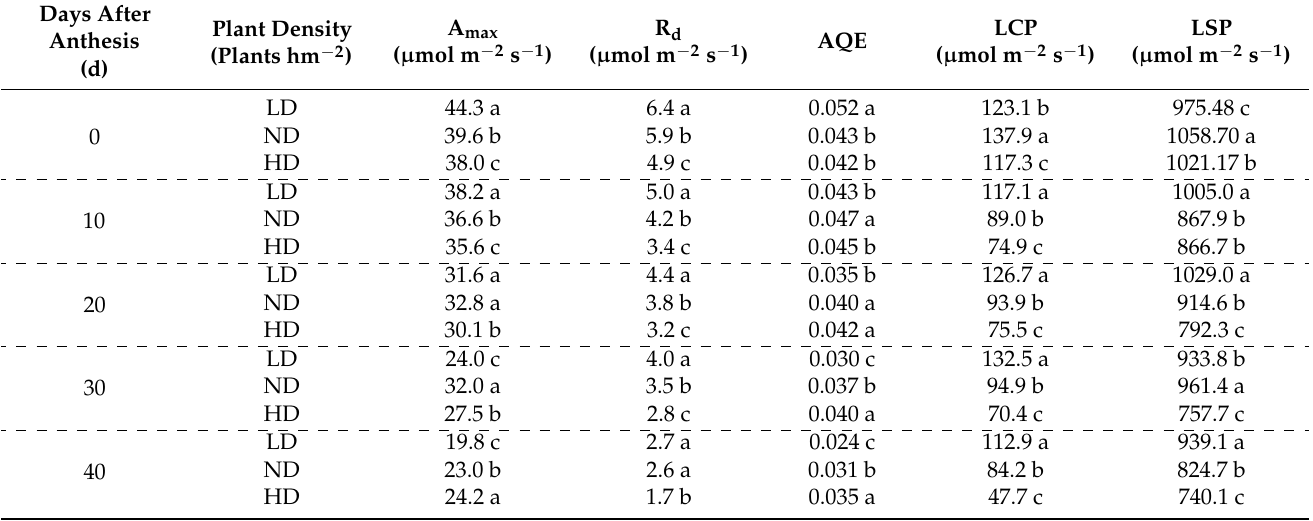
Table 1. Mean values ± SD ( n = 3) of photosynthetic parameters derived from the photosynthetic photon flux density (PPFD) response curves in maize plants grown under low (LD), normal (ND), and high density (HD) planting at 0, 10, 20, 30, and 40 d after anthesis. Different lowercase letters (a, b, c) denote statistical differences by LSD test ( p ≤ 0.05) between different treatments.